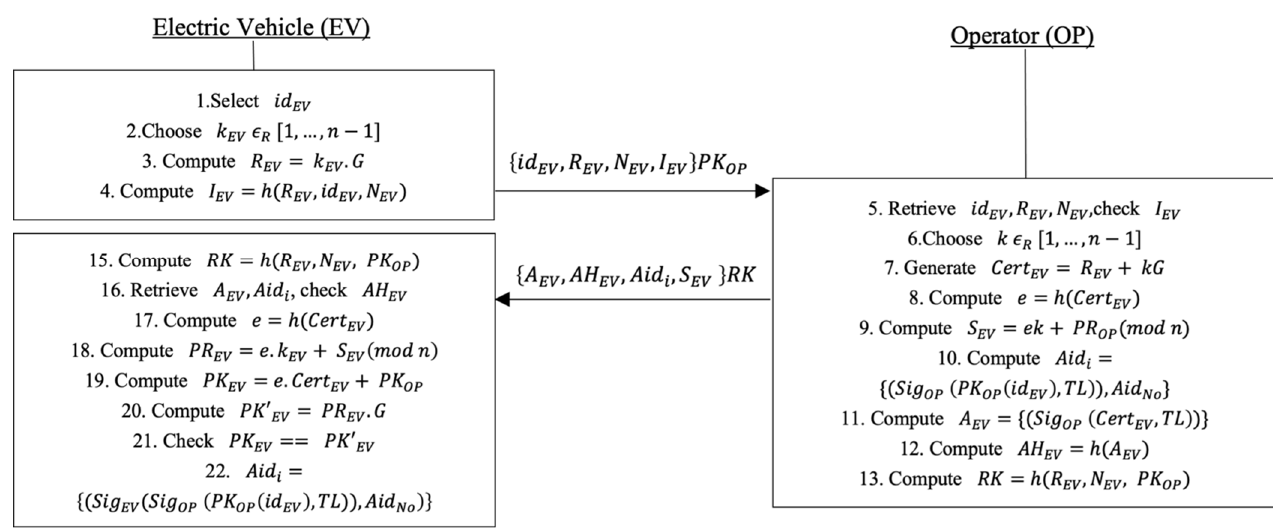
Figure 4. The proposed EV